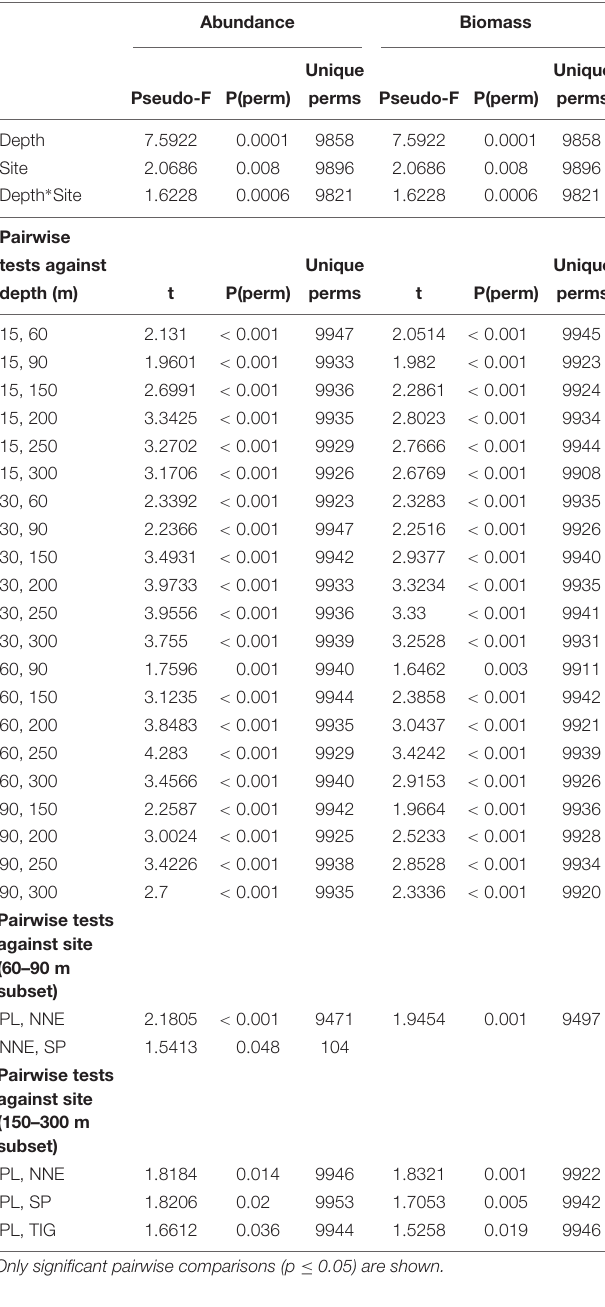
TABLE 1 | Changes of fish community structure in relation to depth and site using PERMANOVA on Bray-Curtis similarity matrices of log(x + 1)-transformed abundance and biomass-weighed data.